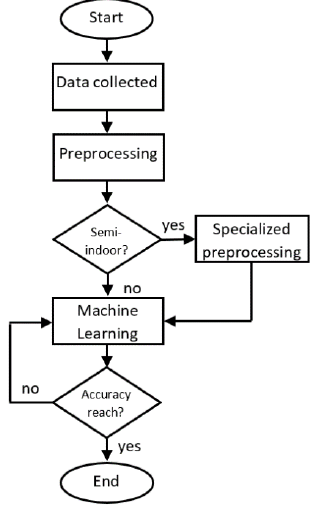
Figure 4. Proposed scheme.